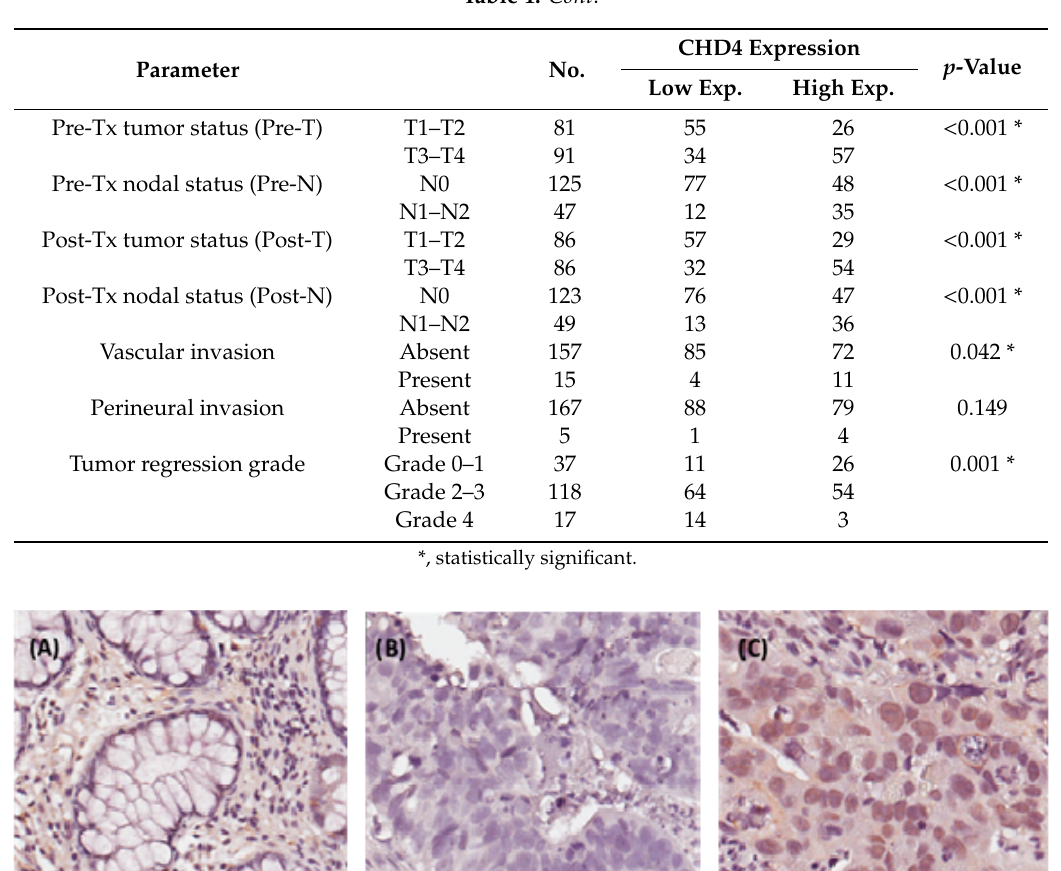
Pre-Tx tumor status (Pre-T)